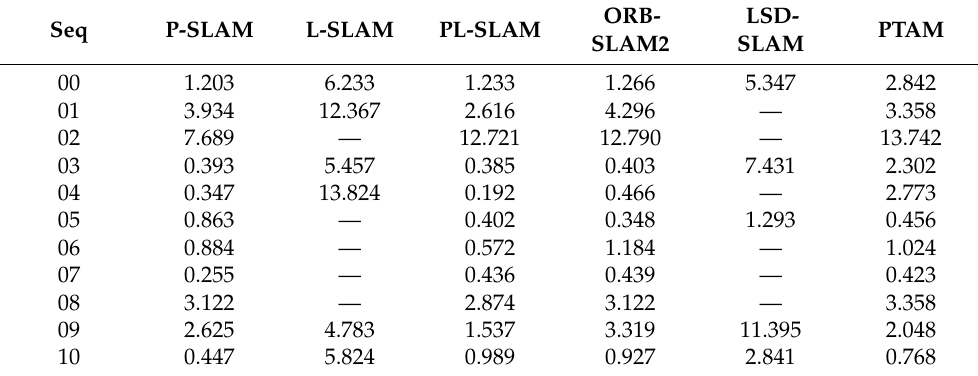
Figure 15. Qualitative evaluation of PL-Net point–line detection knowledge distillation method on the Wireframe dataset and the YorkUrban dataset. Table 3. Results of ablation experiment in term of the RMSE of ATE (Unit: m).